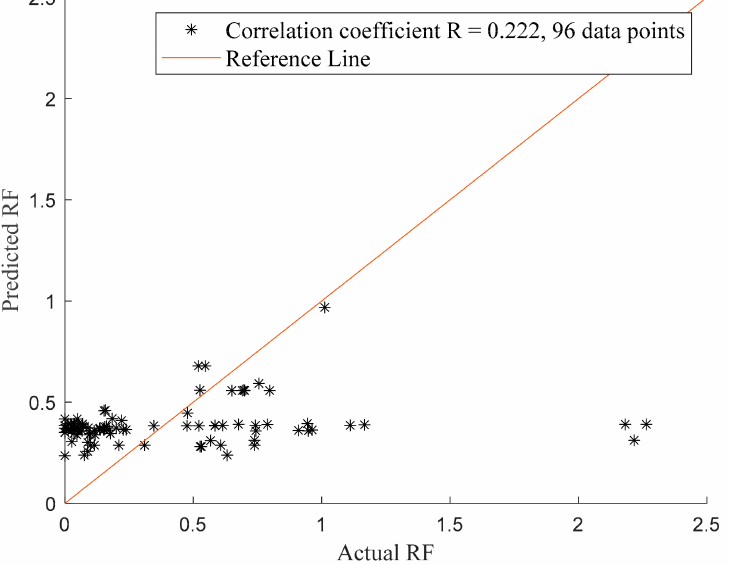
Figure 2. Predicted RF from linear regression and actual RF from experiments for brine parameters (Predicted RF = 0.35 + 1.17 × DC − 1.433 × DS − 0.085 ×